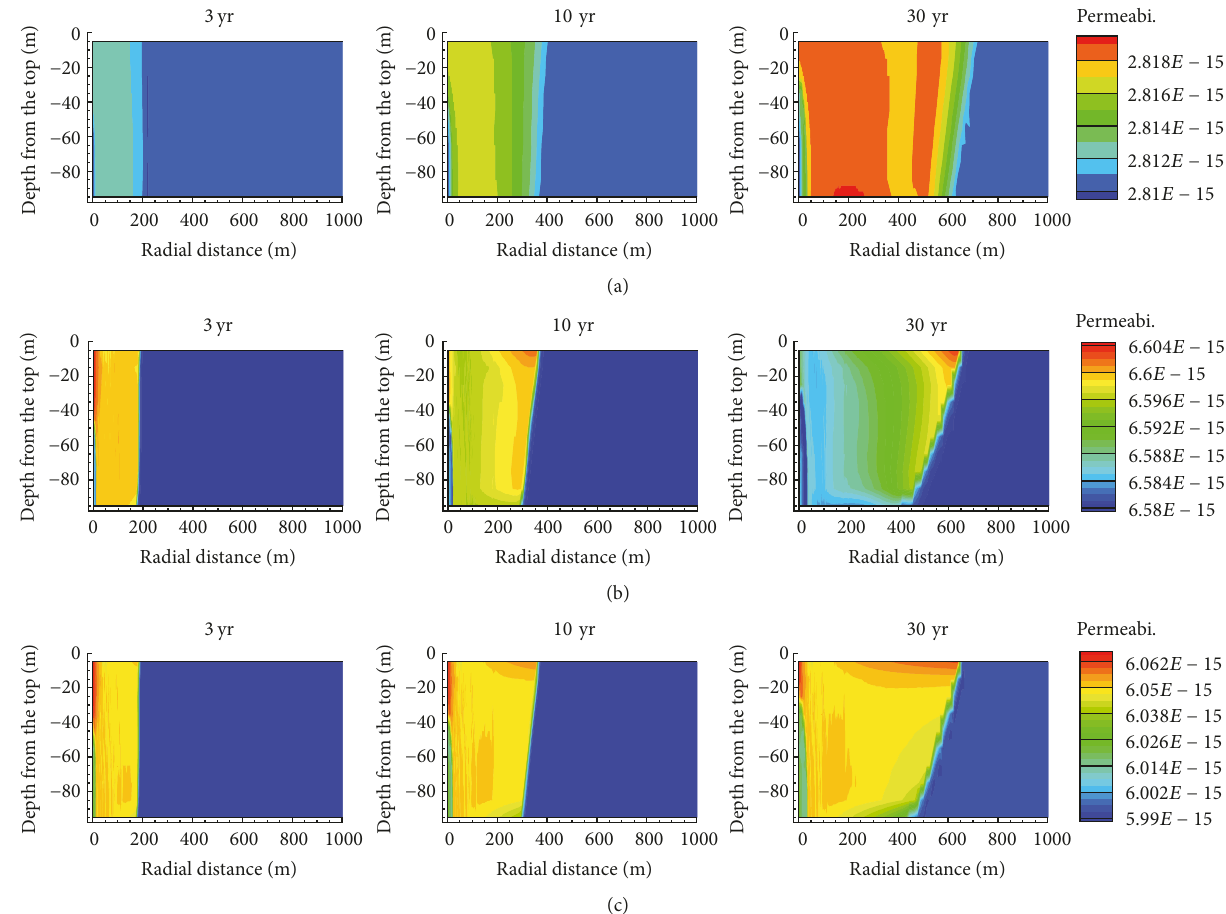
Figure 7: The evolution of permeability in the three formations ((a): Liujiagou formation; (b): Shiqianfeng formation; (c): Shihezi formation).